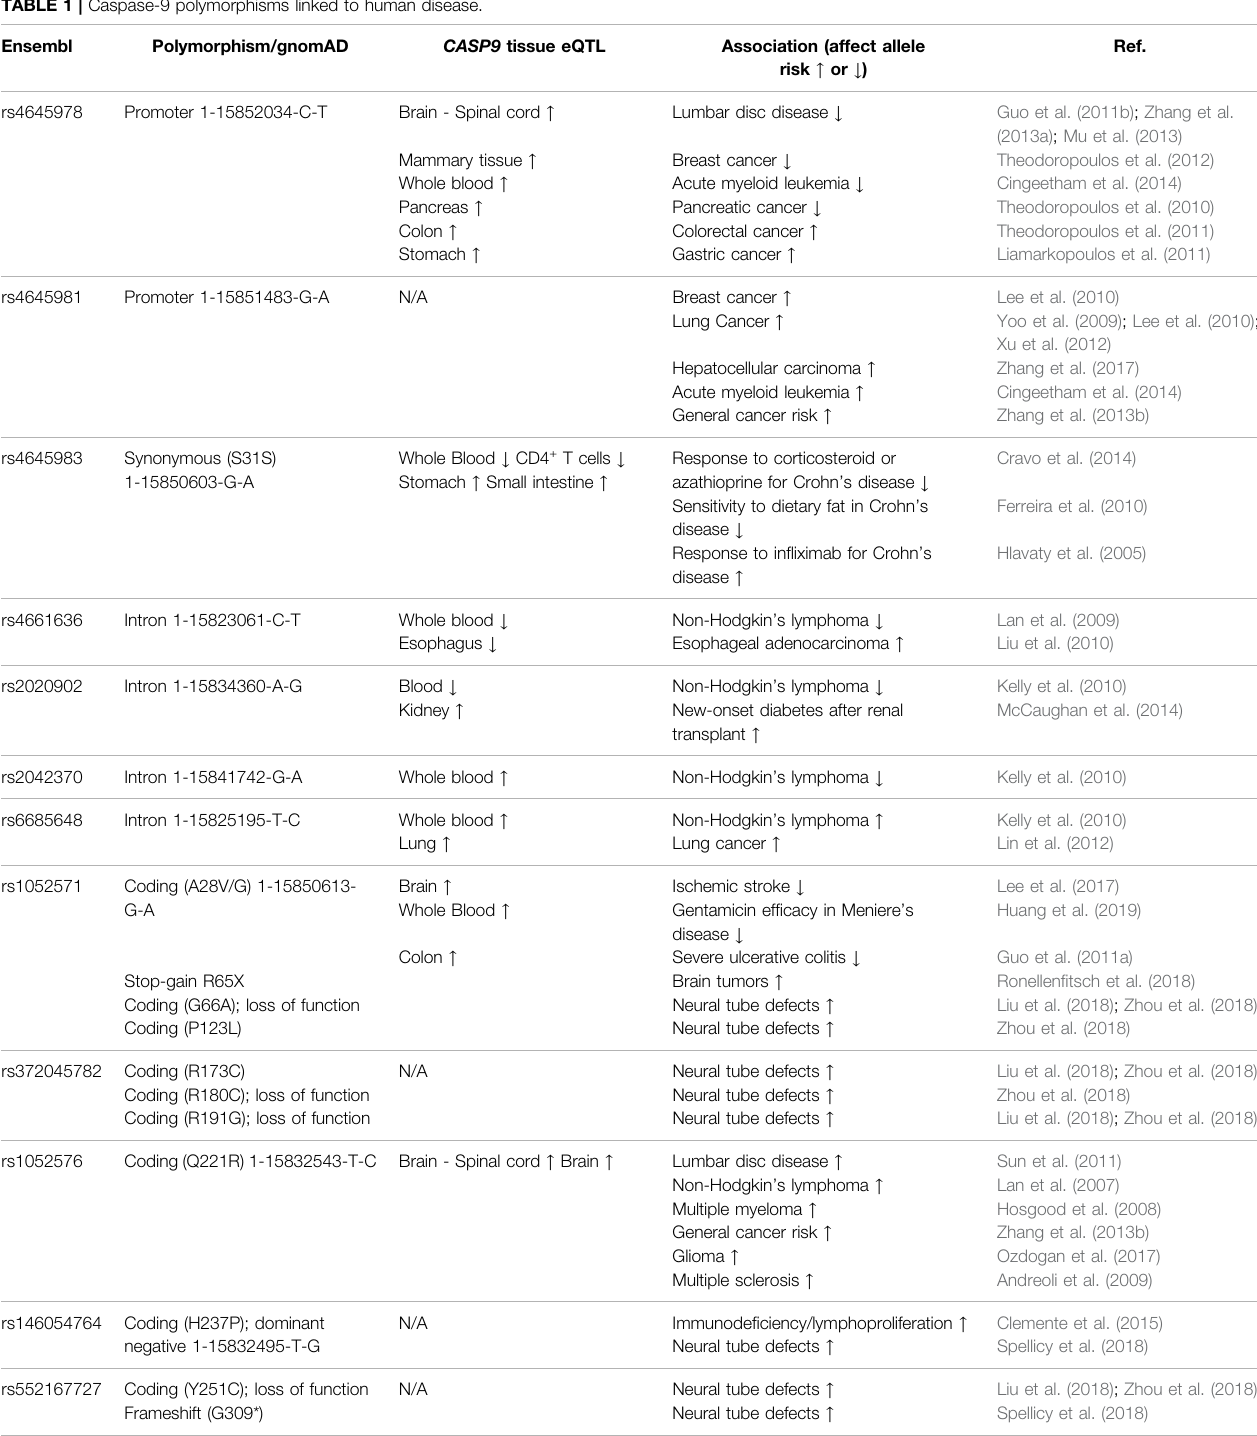
Listofdiseaseassociationsreportedforcaspase-9polymorphisms,andassociatedeQTLs(GTexPortal)indicatingwhethertheSNPsareassociatedwithincreasedordecreasedlevelsof caspase-9 expression. Reference sequence IDs from